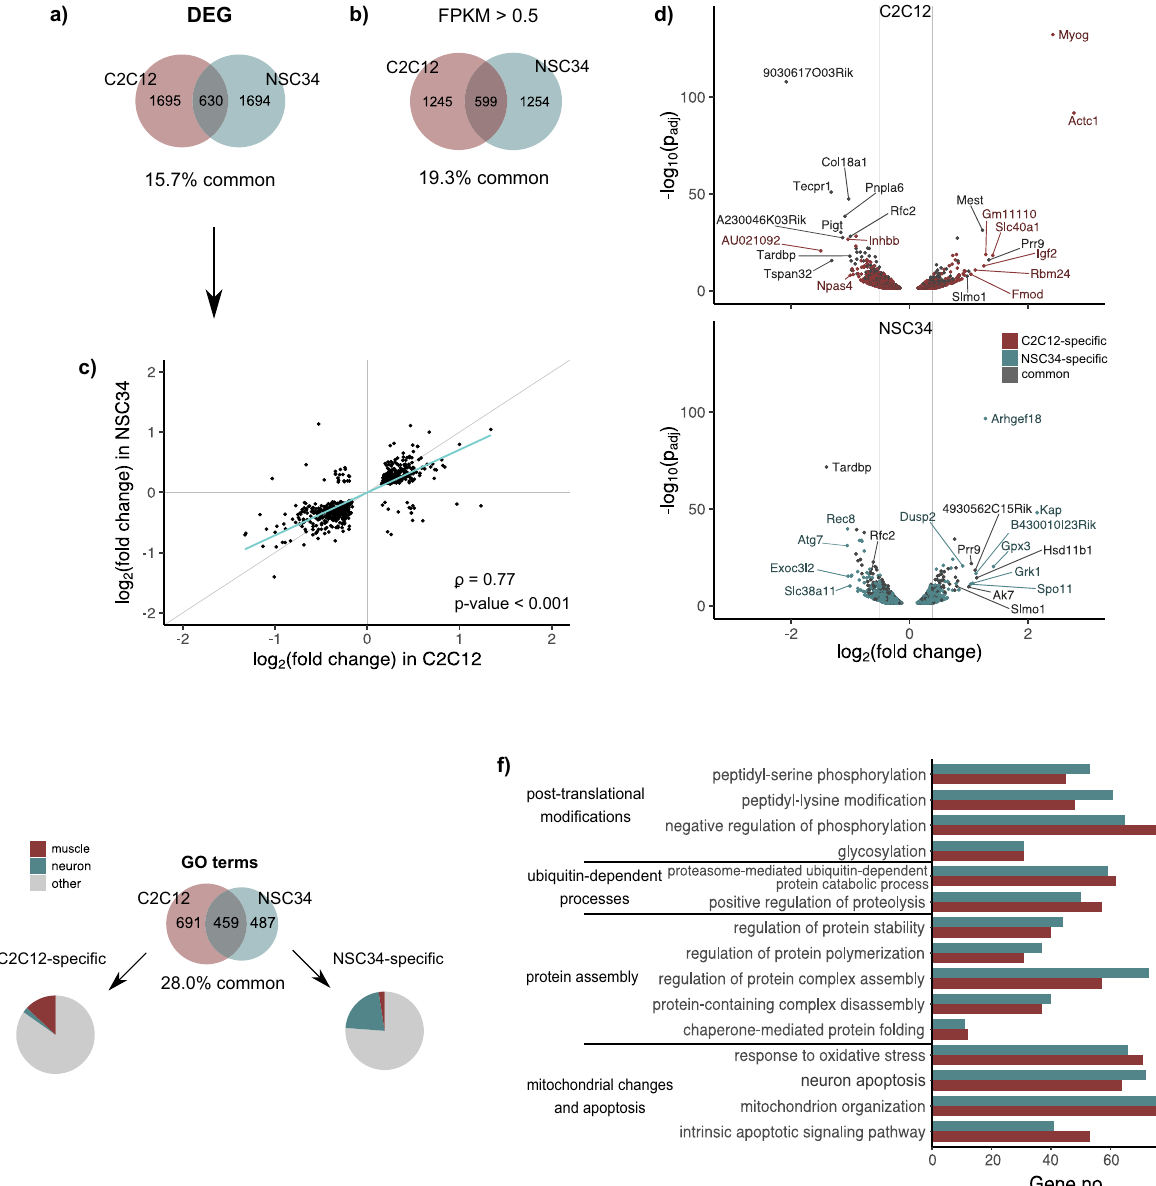
Fig. 2 TDP-43 mediates expression levels of different mRNAs in C2C12 and NSC34 cells. a Venn diagram shows the number of TDP-43-regulated transcripts identi fi ed in C2C12 and NSC34 cells exclusively (1695 and 1694, respectively), along with those that are commonly regulated by TDP-43 in both cell types (630). Transcripts with p adj < 0.05 were considered as differentially expressed irrespective of their log 2 fold change. b Venn diagram shows the overlap (599 transcripts, 19.3%) of TDP-43-regulated DEG identi fi ed in C2C12 and NSC34 cell line (as in a , Supplementary Data 2), considering only transcripts expressed in both cell lines (FPKM in both cell lines > 0.5). Transcripts with p adj < 0.05 were considered as differentially expressed irrespective of their log 2 -fold change. c Expression changes of common targets ( a , Supplementary Data 2, 630) are plotted by their log 2 -fold change values in C2C12 and NSC34 (Spearman ’ s ρ = 0.77, p -value < 2.2 · 10 − 16 ). Grey line represents y = x and the blue line represents the fi tted regression. d TDP-43-mediated expression changes in C2C12 and NSC34 represented as volcano plots. C2C12- and NSC34-speci fi c targets are shown in red and blue, respectively, while common targets are plotted as grey dots. Vertical lines indicate fold changes of 0.7 (30% increase) and 1.3 (30% decrease). Best hits are labelled with gene names. e Venn diagram shows the number of cell-type-speci fi c and overlapping GO terms enriched by DEG identi fi ed in C2C12 or NSC34 cells. GO terms (category: biological process) were grouped based on their names as those implying muscle- (red) or neuron-related features (blue). f Representative GO terms (category: biological process) commonly enriched by DEG in C2C12 and NSC34 cells suggesting pathological abnormalities described in neurodegenerative and myodegenerative disease (hand